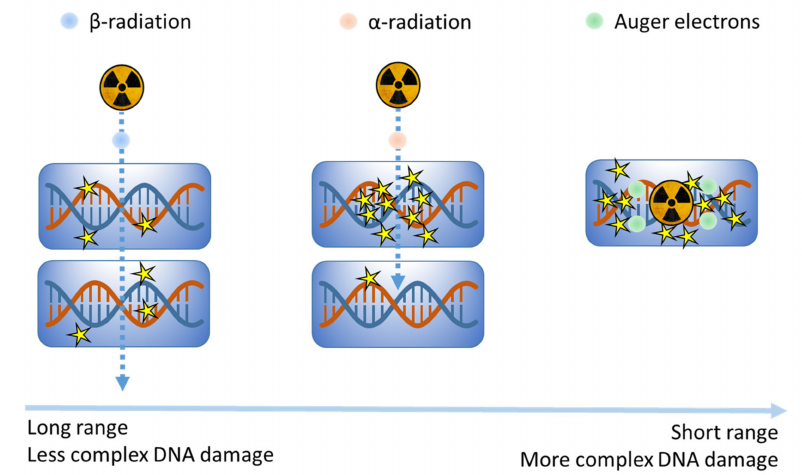
Figure 3. Visualization of DNA damage induction patterns of beta-emitters, alpha-emitters and Auger electrons, ordered (from left to right) by decreasing penetration range and increasing complexity of induced DNA damage. While beta-emitters exhibit a relatively long penetration range, they mostly induce isolated lesions. Alpha-emitters have a shorter range, but can locally induce more complex forms of DNA damage that are less readily repaired. Auger electrons display the shortest range of the three, but due to the fact that multiple electrons are released from the radionuclide they can still induce a high biological e ff ect